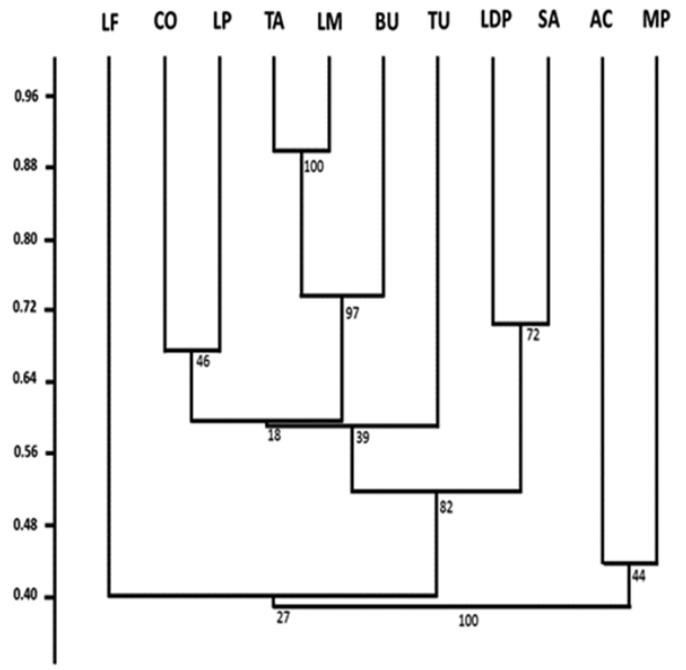
Figure 2. Dendrogram generated from the values of DSI between ichthyocenoses recorded in limnic sys- tems of Rio Grande do Sul Quaternary deposits. Key: AC (Rio Grande coastal streams; Tagliani [1995]), BU (Tapes Butiazais ; Becker et al. [2007]), CO (Corrientes Stream; Volcan et al. [2012]), LDP (Lagoa do Peixe; Loebmann and Vieira [2005]), LF (Lagoa Fortaleza; Schifino et al. [2004]), LM (Lagoa Mangueira; Artioli et al. [2009]), LP (Lagoa Pequena marginal marshes; present study), MP (Peat forest; Quintela et al. [2007]), SA (Cassino coastal streams; Bastos et al. [2013]), TA (Taim wetland; Garcia et al. [2006]), TU (Turuçu River basin; Burns et al.